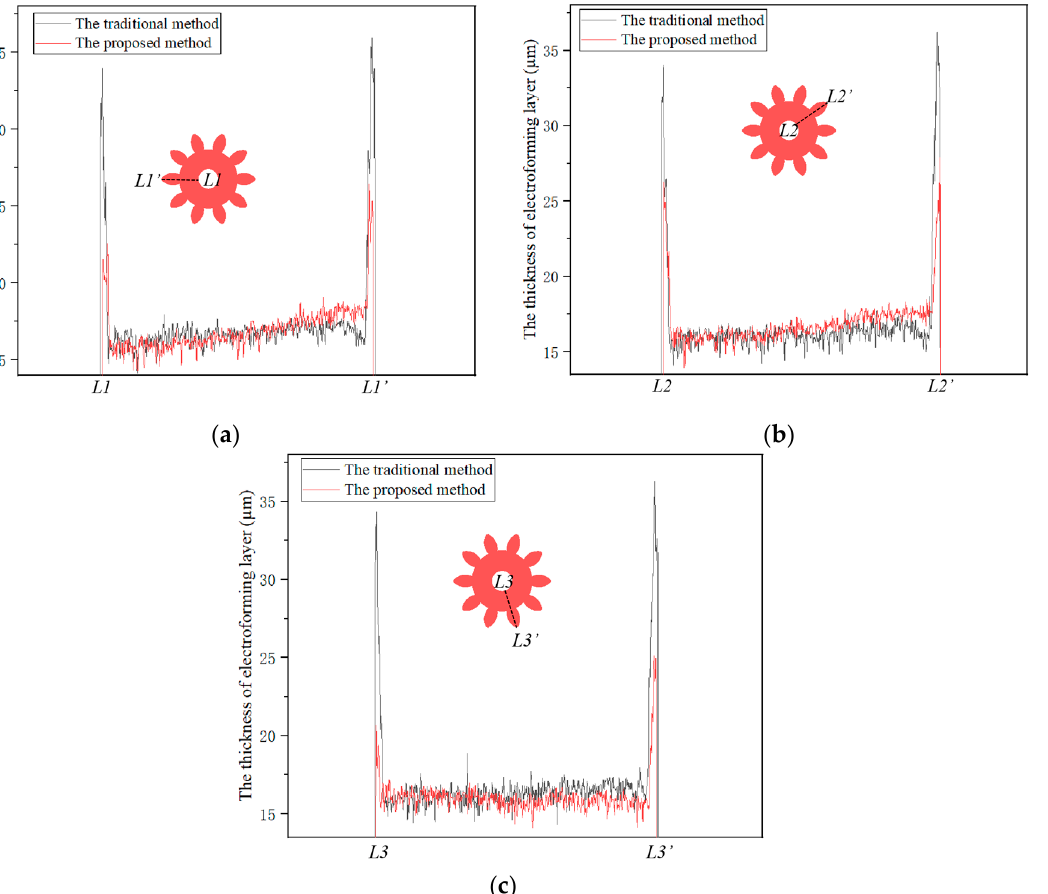
Figure 6. FE-SEM images of fabricated micro gear structures. ( a ) FE-SEM images in the traditional method; ( b ) FE-SEM images in the proposed method.